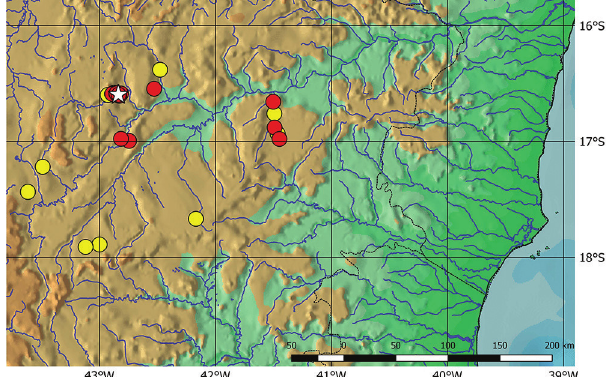
Fig. 3. Distribution of Pareiorhaphis lineata in eastern Brazil. Red dots = paratypes; star = type-locality; yellow dots = non-type specimens. Each symbol may represent more than one lot or locality.